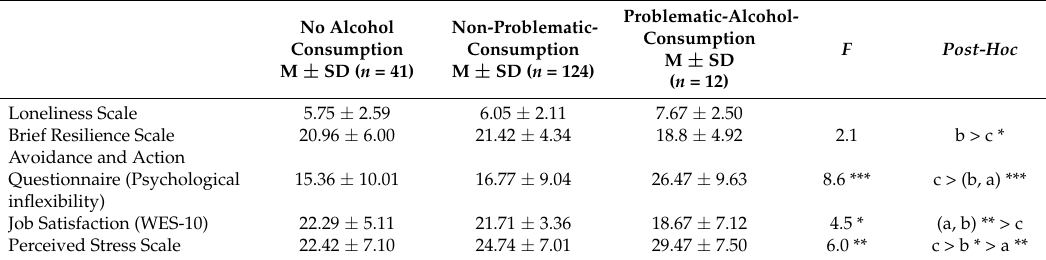
Table 3. Psychosocial variables associated with the alcohol consumption level (AUDIT) in female professors ( n = 177).